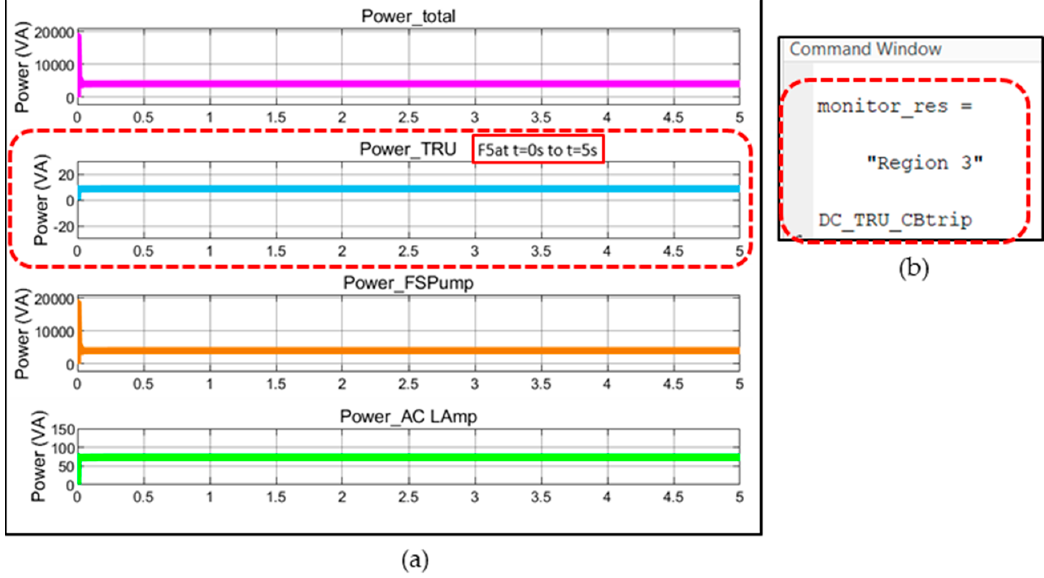
Figure 14. ( a ) Corresponding reaction in apparent power for DC_TRU_CBtrip (F5) fault injection. ( b ) Method 2 results with the ANFIS monitor and causal reasoning .